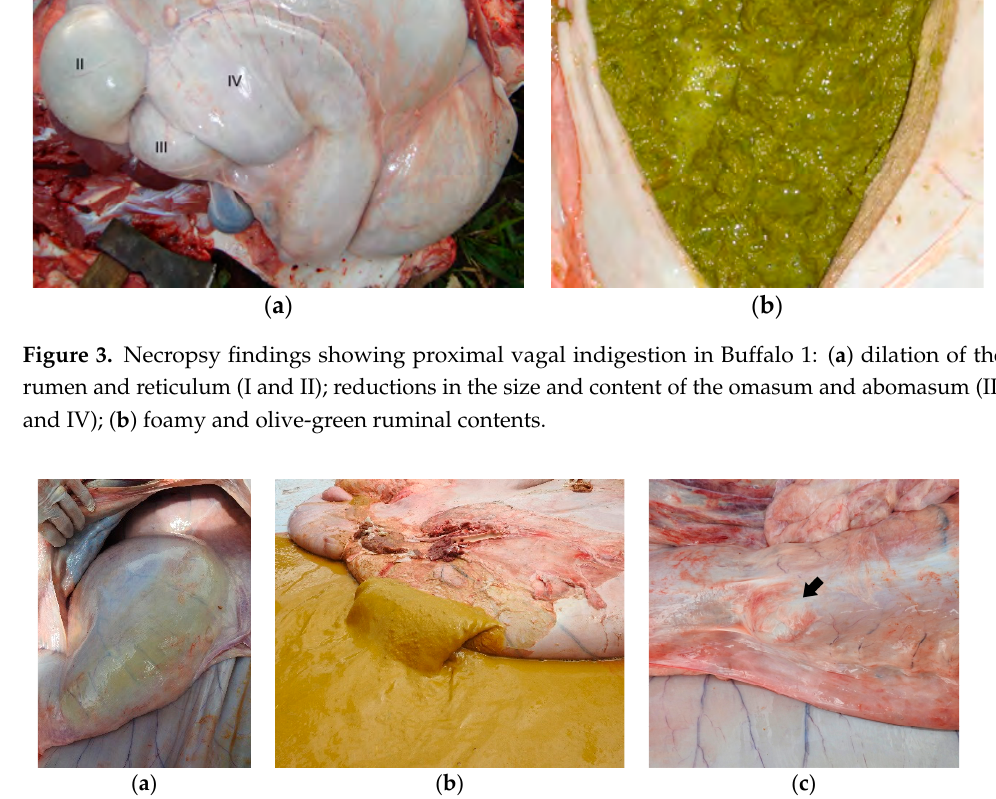
Figure 4. Distal vagal indigestion in Buffalo 2: ( a ) Bilateral distention of the abomasum; ( b ) Semiliquid (solid intermixed with liquid) and yellowish-color ruminal contents; ( c ) Region of the pylorus in which the area was removed from the eventration (arrow).